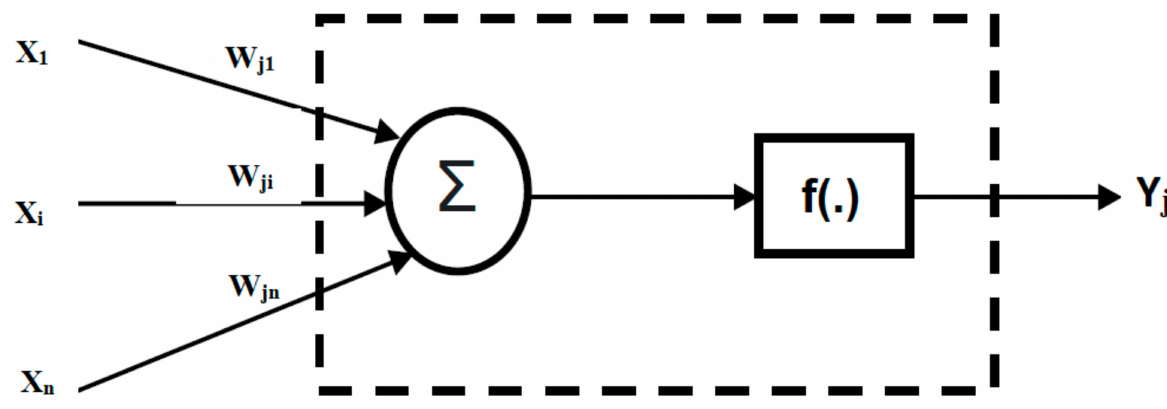
Figure 6. Process in multilayer perceptron